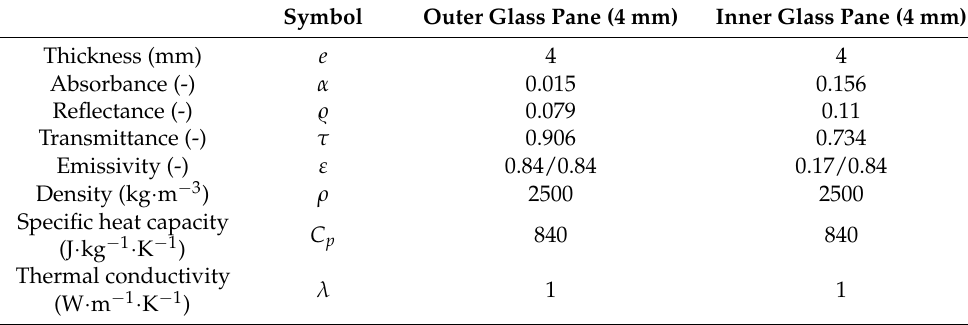
Table 2. Assumed properties of the outer and inner glass panes.